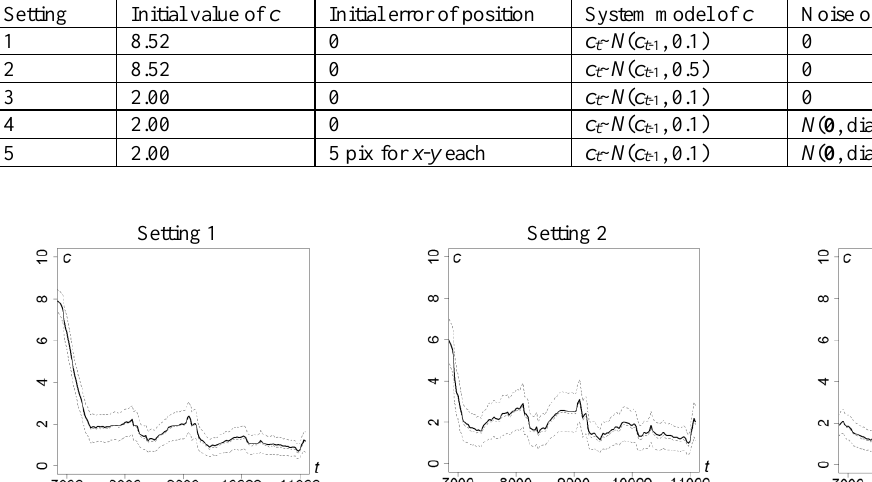
Table 4. Setting for analyses